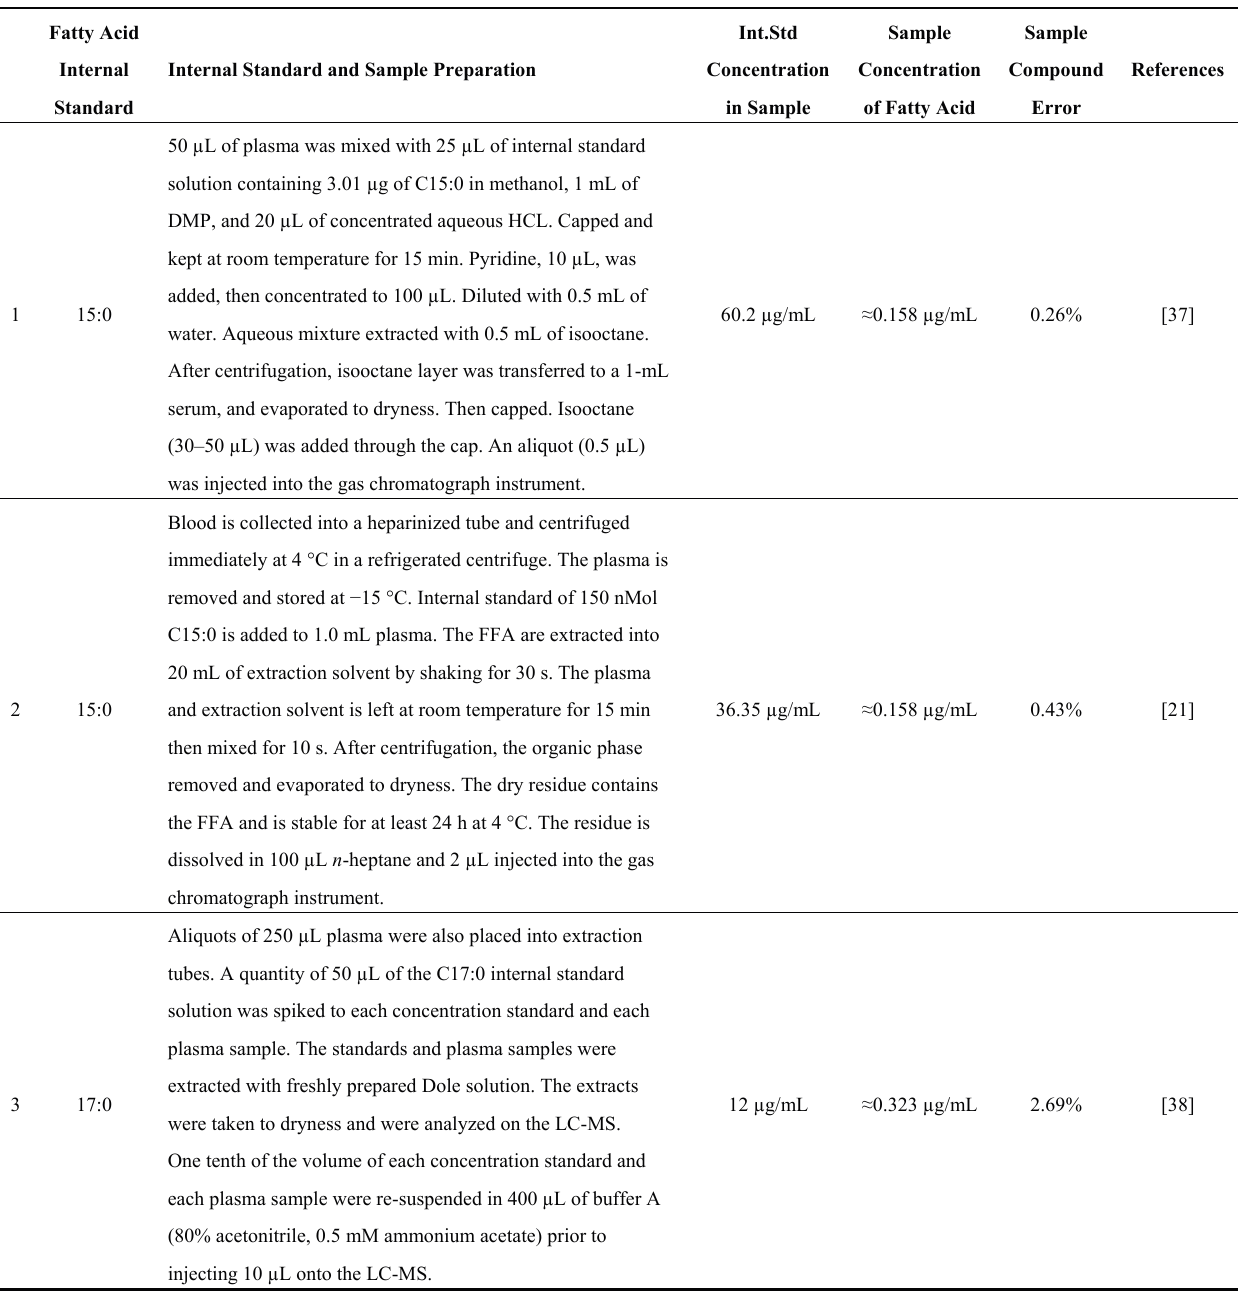
Table 2. The estimated error associated with the use of endogenous compounds containing. C15:0 and C17:0 as internal standards. For each study the added amount of internal standard and the possible sample endogenous concentration are shown, allowing the calculation of the possible error of the measured abundance of each of the fatty acid internal standards